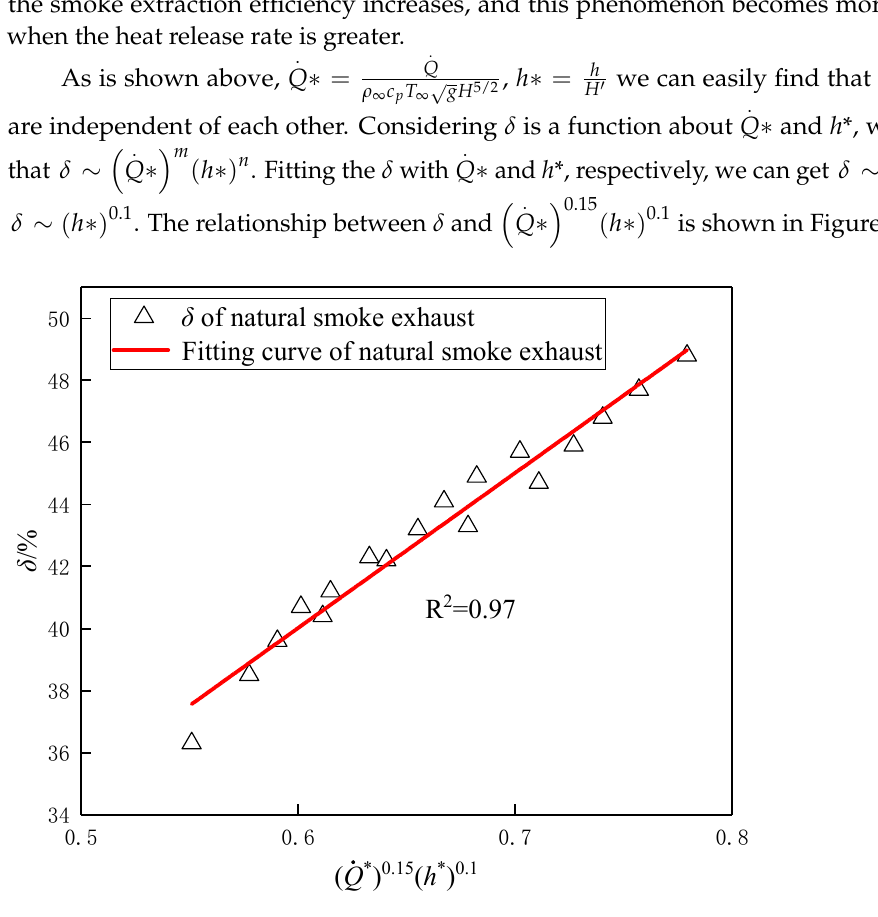
Figure 7. Natural smoke exhaust fitting line.